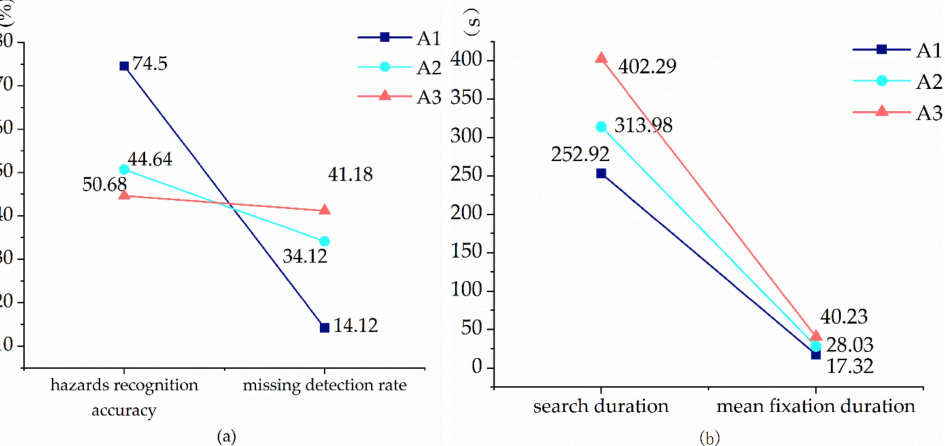
Figure 8. Comparison chart of hazard recognition data for three groups of workers. ( a ) Comparison of hazards recognition accuracy and missed detection rate of workers. ( b ) Comparison of the search duration and mean fixation duration of the workers’ hazard